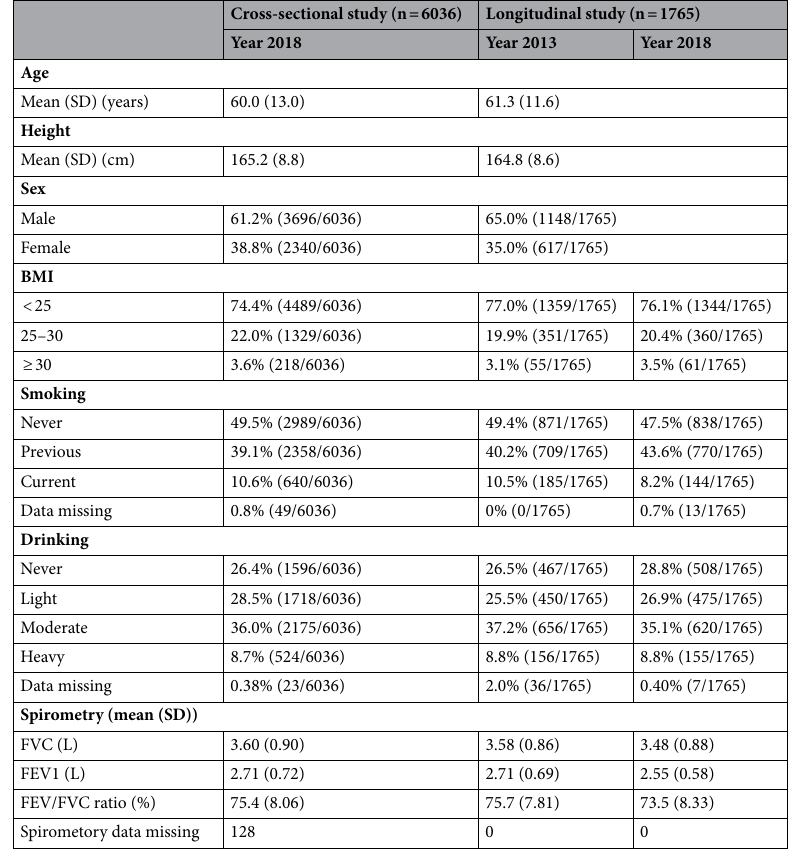
Table 1. Characteristics of subjects of the cross-sectional and longitudinal studies. Characteristics (age, height, sex, BMI, smoking status, total alcohol consumption and spirometry) of subjects of the cross-sectional study who received health checkup in 2018 at Keio University Hospital and subjects of the longitudinal study who received health checkups at Keio University Hospital in 2013 and 2018.